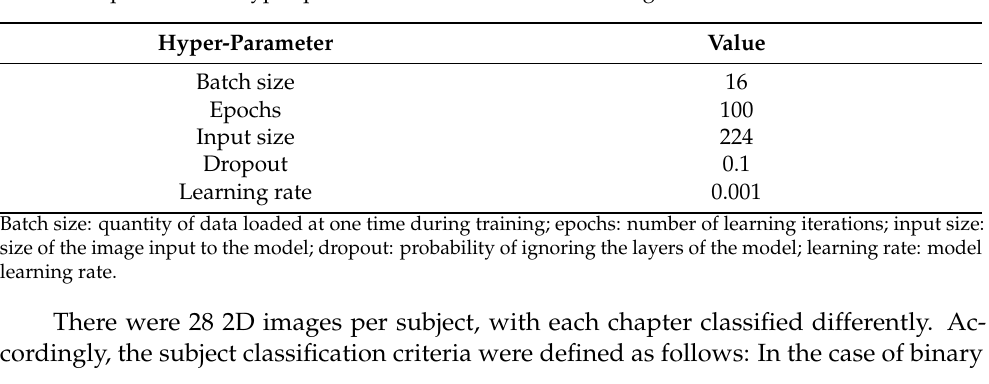
Table 3. Representative hyper-parameters used for model